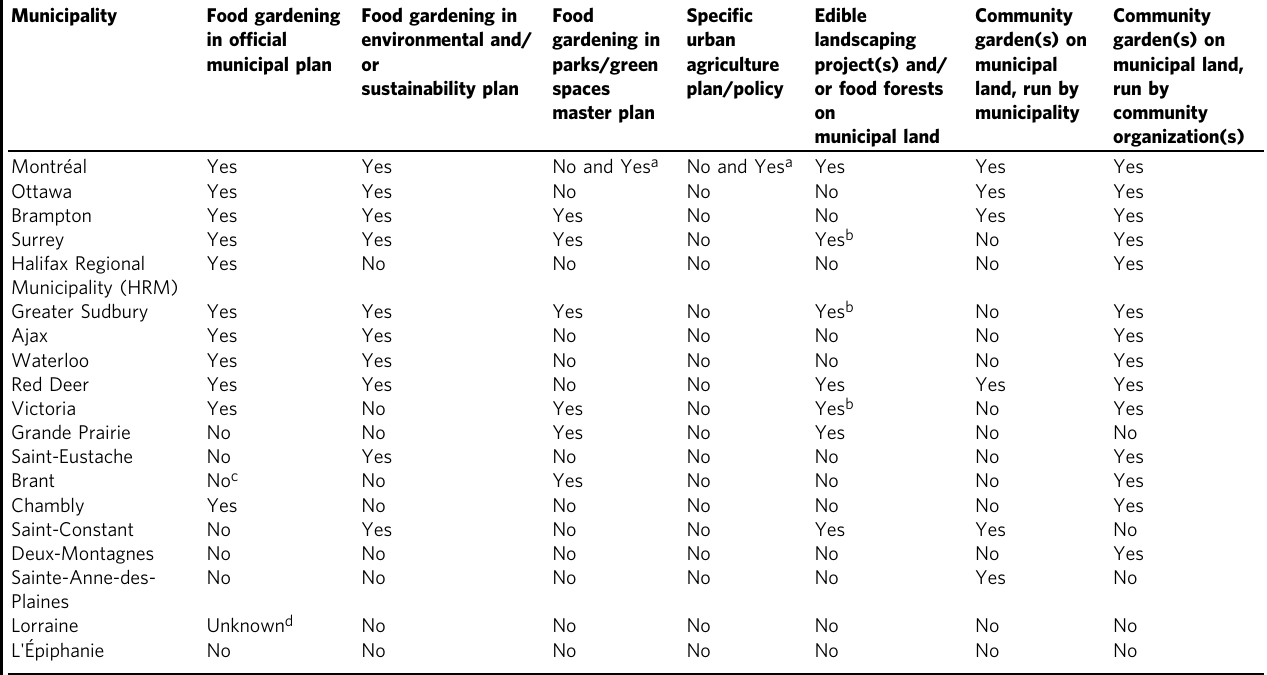
Table 4 Food gardening in signi fi cant municipal plans and reports, and food gardening programs.